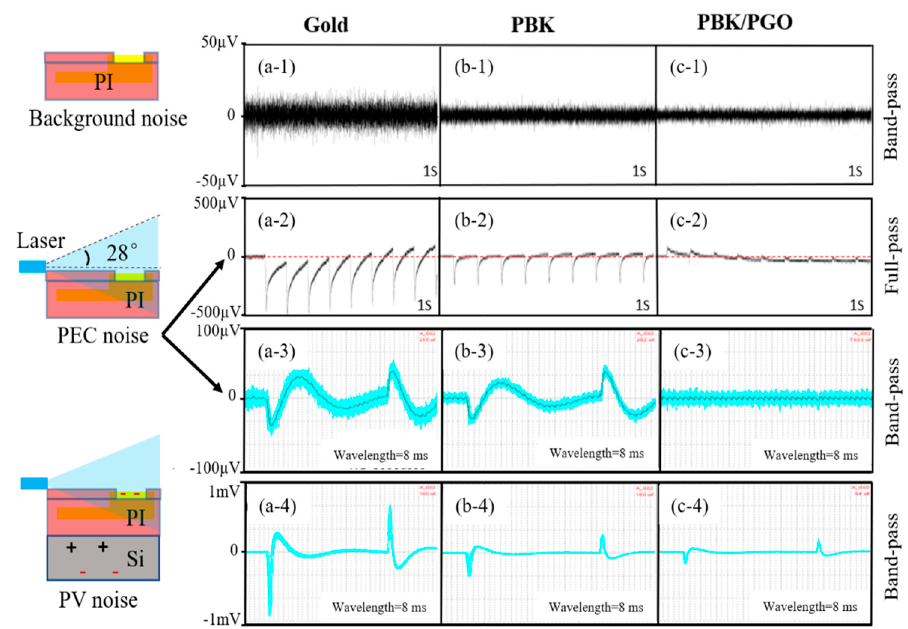
Figure 6. Background noise recorded from ( a-1 ) gold microelectrode, ( b-1 ) PBK modified microelectrode, and ( c-1 ) PBK/PGO modified microelectrode under laser pulse stimulation (0.2 A, 5 ms, 10 Hz) on bench. Recorded ( a-2 , b-2 , c-2 ) full-pass and ( a-3 , b-3 , c-3 ) band-pass PEC noise of PI-based probe under laser pulse stimulation (0.2 A, 5 ms, 10 Hz, n = 100). ( a-4 , b-4 , c-4 ) Recorded photoelectric artifacts of silicon-based probe under laser pulse stimulation (0.1 A, 5 ms, 10 Hz, n = 100).